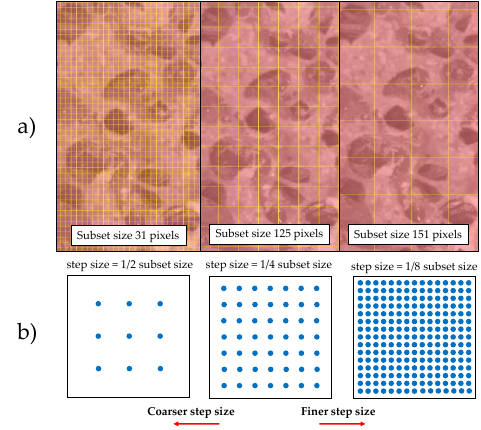
Figure 4. Representation of ( a ) step and ( b ) subset sizes variation.